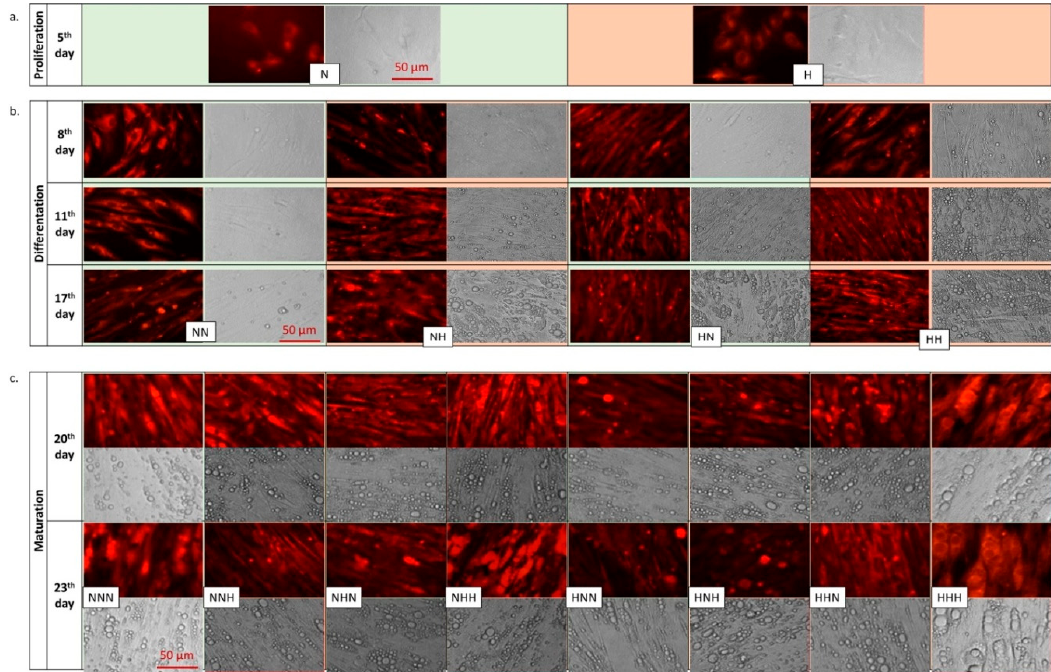
Figure 1. Morphological changes of human visceral p/Ads during ADG undernormoglycemic and chronic/intermittent hyperglycemic conditions, applied throughout the entire period of culture. Cells stained ( a ) at the termination of the proliferation stage, ( b ) during and at the termination of the differentiation stage and ( c ) during and at the termination of the maturation stage. Cells were stained with BODIPY 505/515 and analyzed under an inverted fluorescence microscope (Olympus IX70), with a magnification ×400 underthe conditions of fluorescence (upper panel of NG or HG, respectively) or phase contrast (lower panel of shown photos).